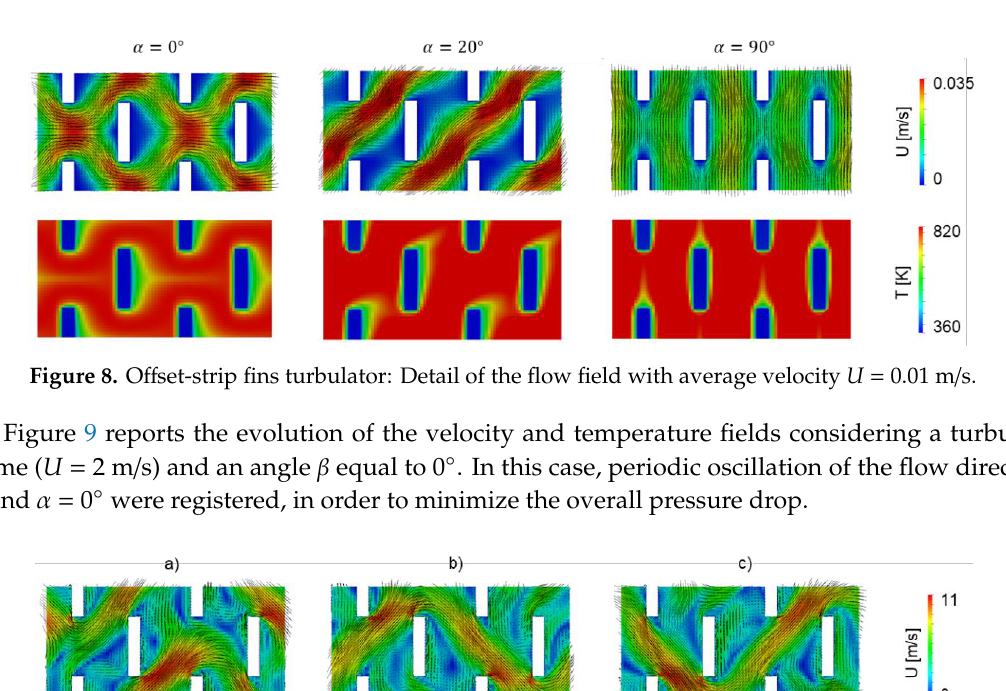
Figure 9. Time evolution of the instantaneous flow field with average velocity U = 2 m/s and momentum source direction α = 0°.